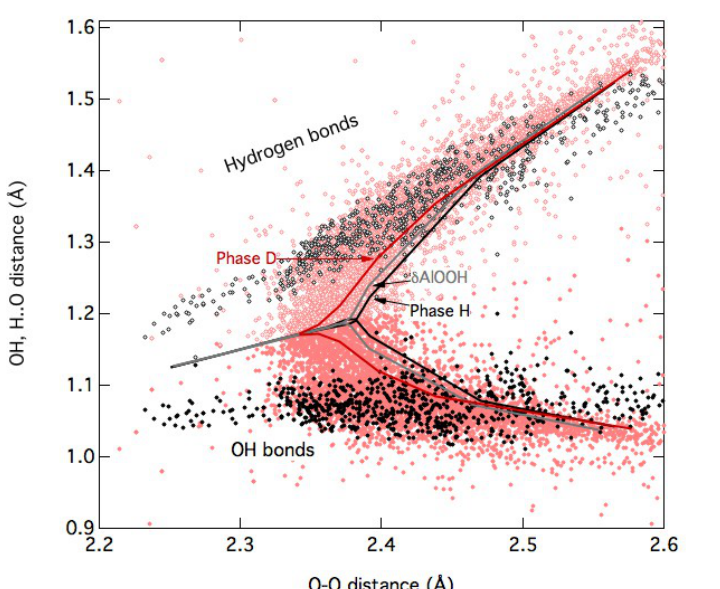
Figure 4. MgSi 2 O 6 H 2 phase D OH and OH..O bond distances as a function of O–O distance (dark red lines), as compared to δ -AlOOH (grey lines) and phase H (black lines). The suite of all phase D OH (pink, filled) and OH..O (pink, open) solid solutions shows an increasing fraction of symmetric bonds with increasing pressure, in contrast with bond distances in phase H solid solutions